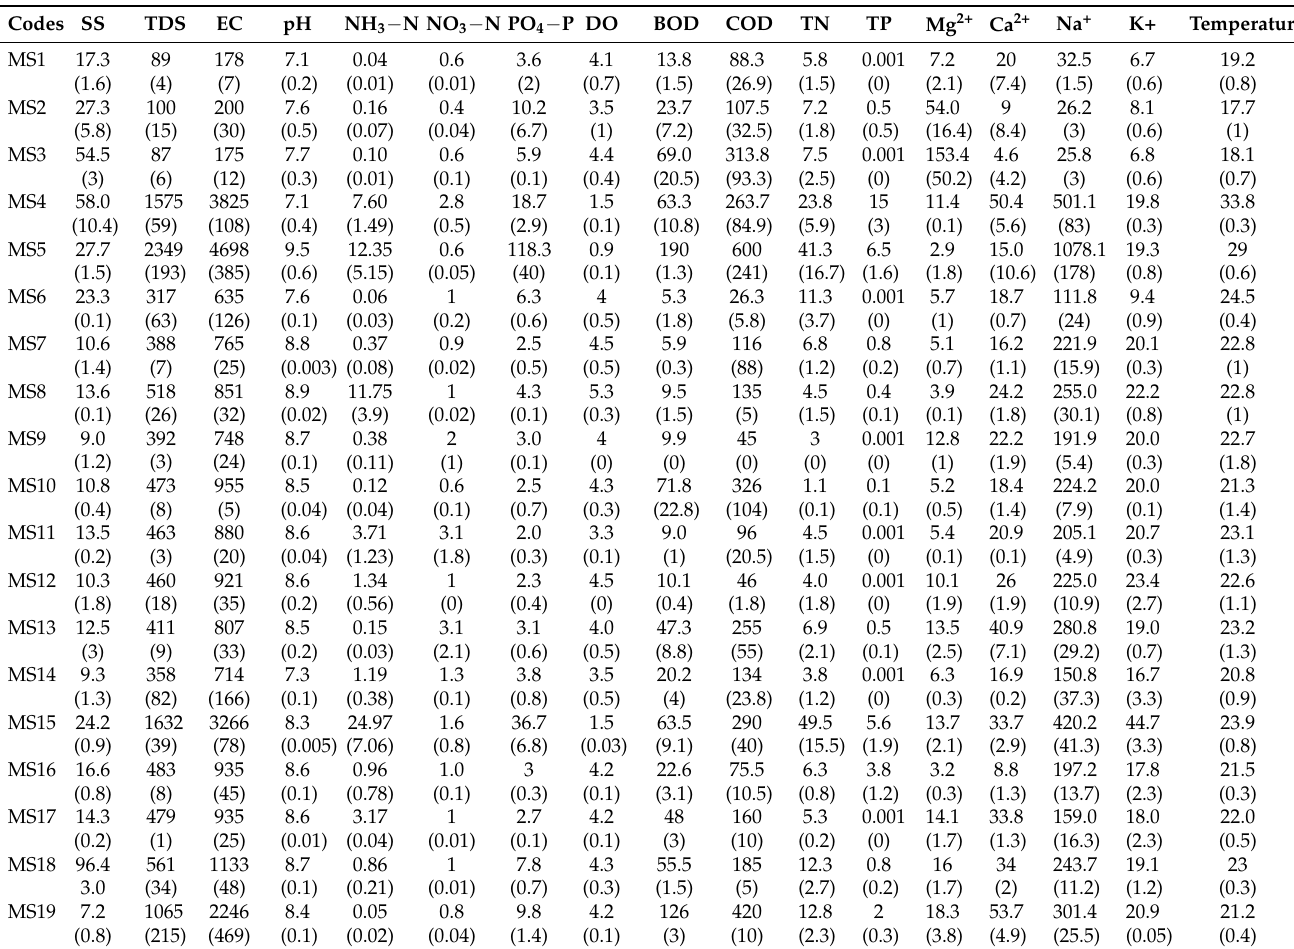
Table 6. Descriptive statistics (mean and standard deviation) of the physicochemical characteristics of LHW collected during dry